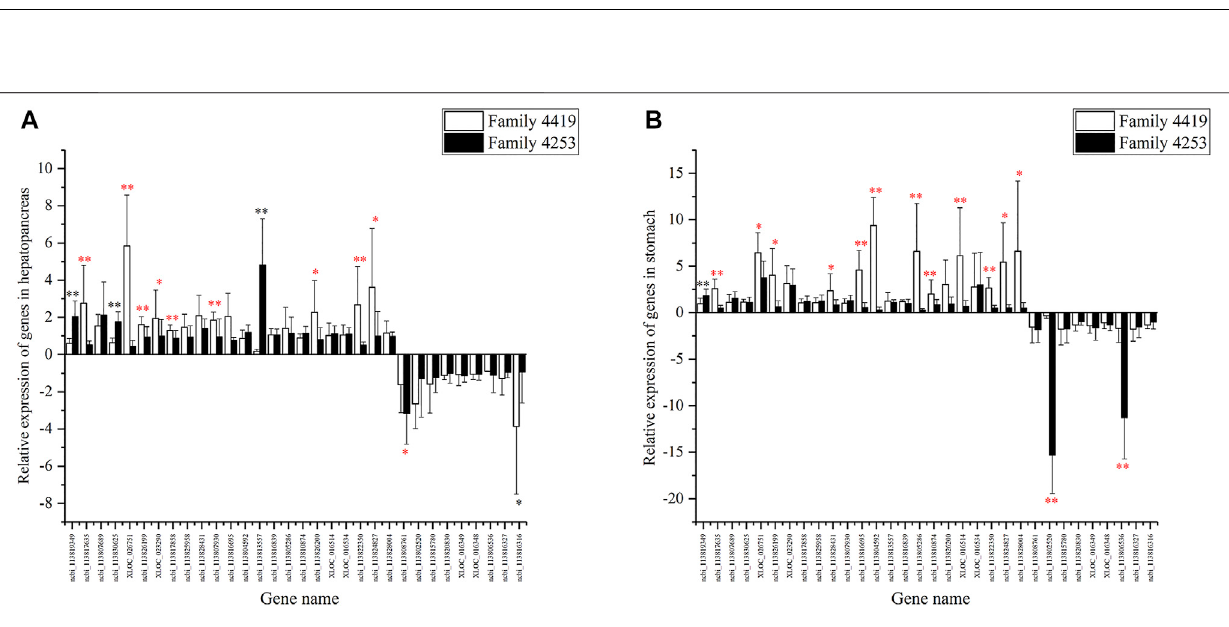
FIGURE7 | The relative expression of 32differentially expressed genes (DEGs) in hepatopancreas (A) and stomach (B) from resistant family 4253 and susceptible family4019.Thesedataareexpressed asthemean ± SDrelativetothereferencegene(18SrRNA).Astatisticallysigni fi cantdifferenceisindicatedwith*( p < 0.05)and** ( p < 0.01). Successfully veri fi ed genes are marked in red. Unsuccessfully veri fi ed genes are marked in black or without any